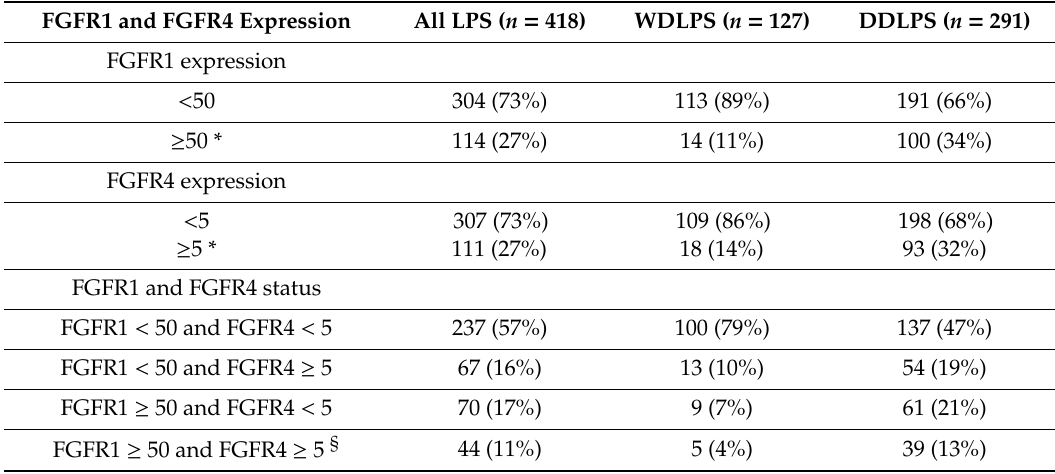
Table 1. Distribution of FGFR1 and FGFR4 immunohistochemical expression in our series of 418 cases of WDLPS and